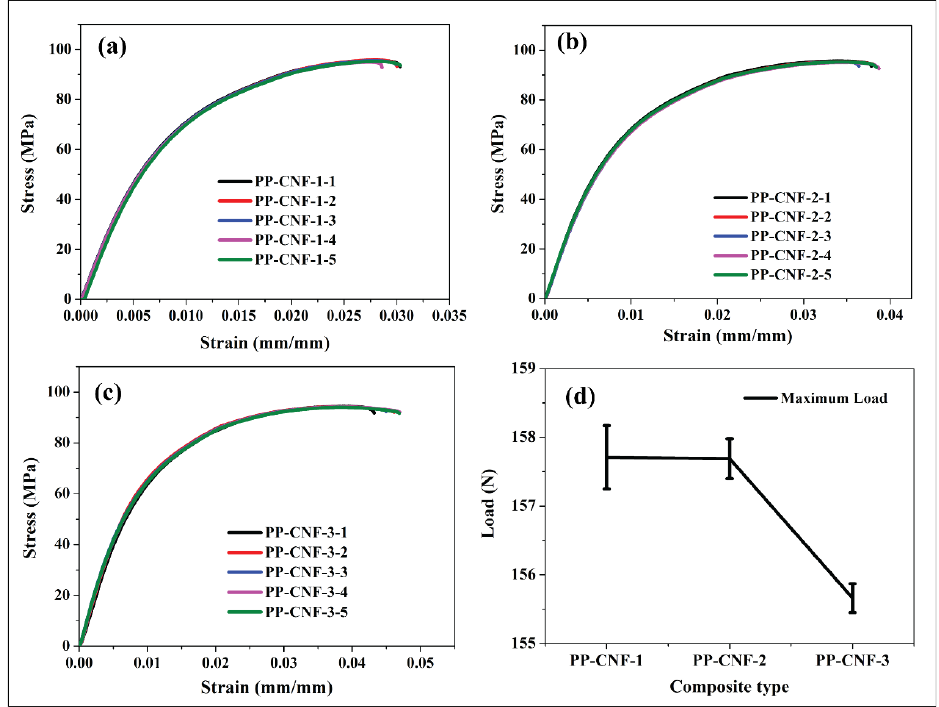
Figure 3. Stress-strain curve of ( a ) PP-CNF-1, ( b ) PP-CNF-2, ( c ) PP-CNF-3, and ( d ) Maximum load variation with different composite type.